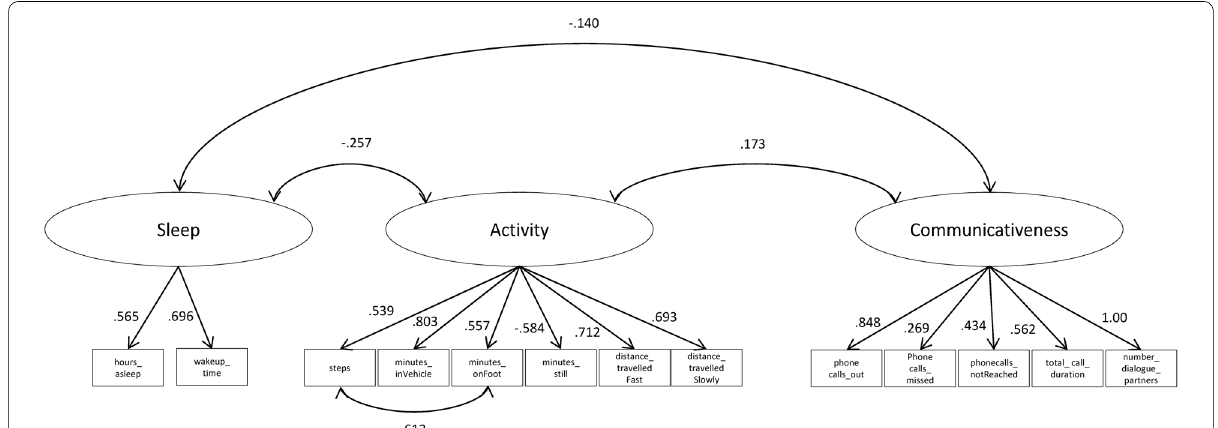
Fig. 2 Model with three latent factors for the domains of sleep, activity, and communicativeness, based on 13 smartphone parameters, showing within‑subject standardized factor loadings and correlations. All correlations and factor loadings are statistically significant (p <